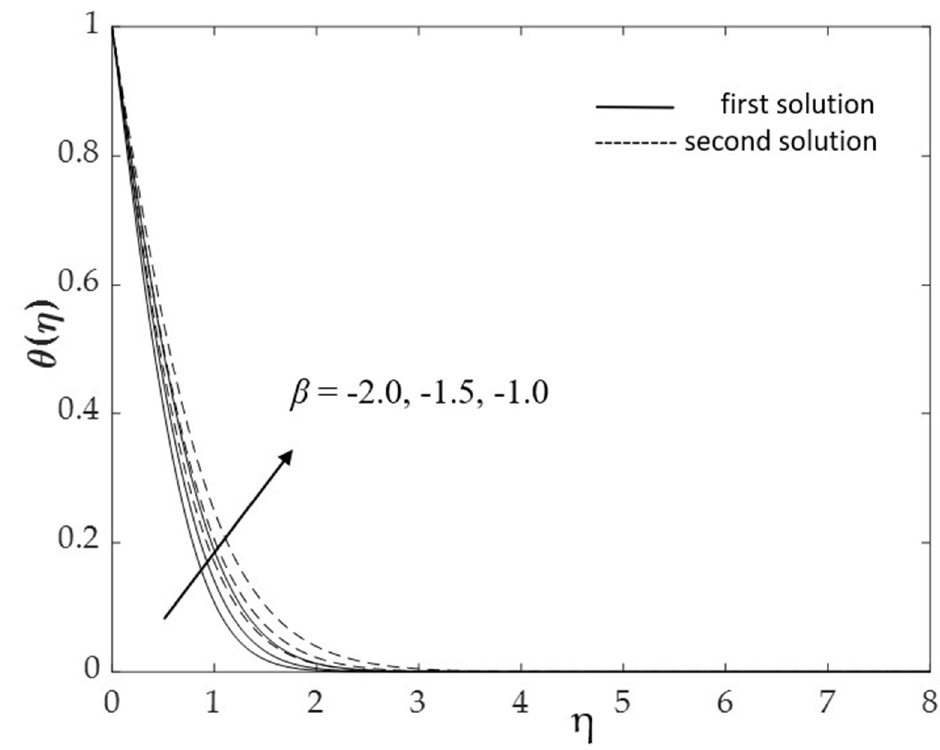
( ) θ η β = for different values of when Pr 6.2 , 2.3 Rd =